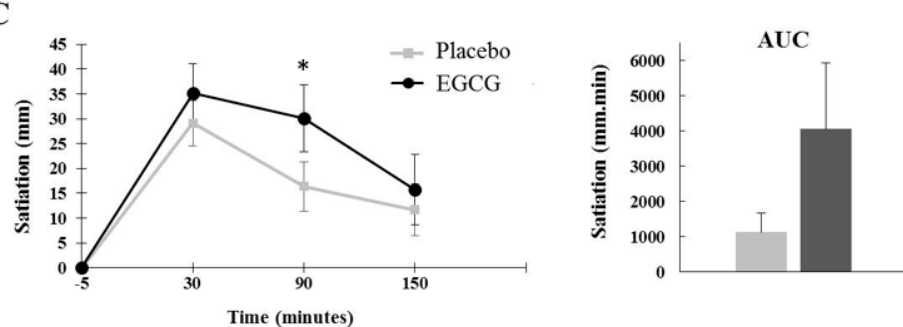
Figure 4. Variations in hunger sensation ( A ), desire to eat ( B ) and satiation ( C )—Visual Analogue Scale (VAS). Perception of hunger, desire to eat and satiation variations assessed with VAS and the area under the curve (AUC) between treatments (placebo × EGCG) were evaluated using the two-way ANOVA (adjusted to individual variation). Values are mean ± SEM. Differences found are highlighted with * ( p < 0.05).